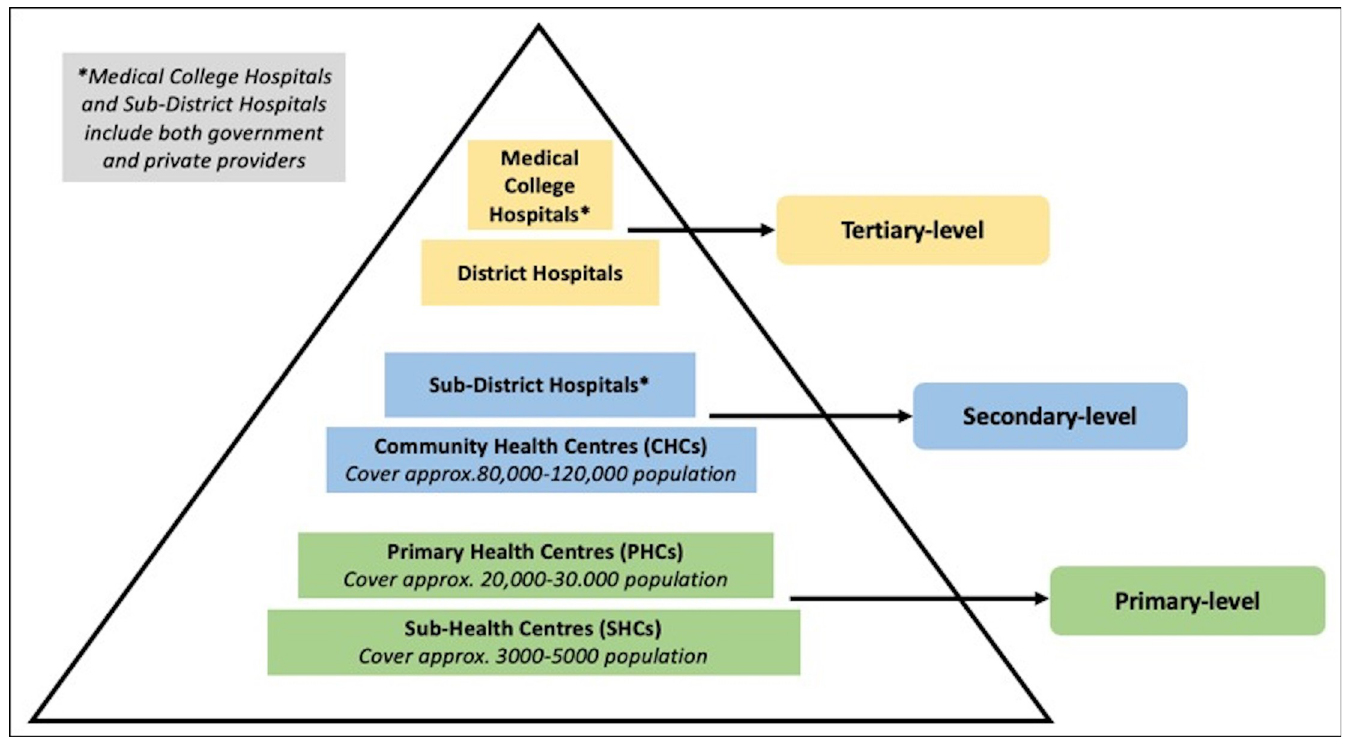
Fig 1. Structure of the Indian public healthcare system according to Indian Public Health Standard Norms.